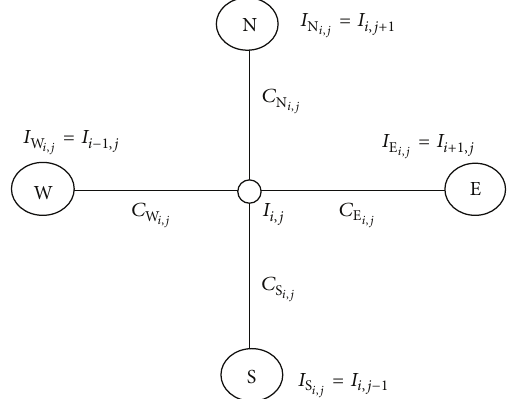
Figure 1: The structure of the discrete computational scheme for simulating the diffusion equation. The brightness values 𝐼 𝑖,𝑗 are associated with the nodes of a lattice and the conduction coefficients 𝐶 with the arcs. One node of the lattice and its four north, east, west, and south neighbors are shown